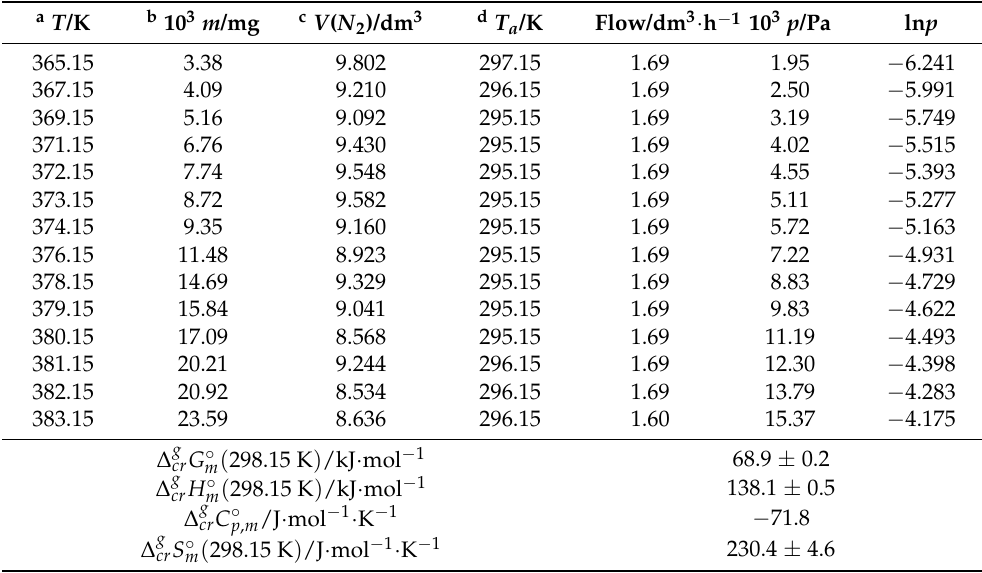
Table 1. Transpiration experiment parameters, vapor pressure of IVZ at different temperatures and standard sublimation thermodynamic